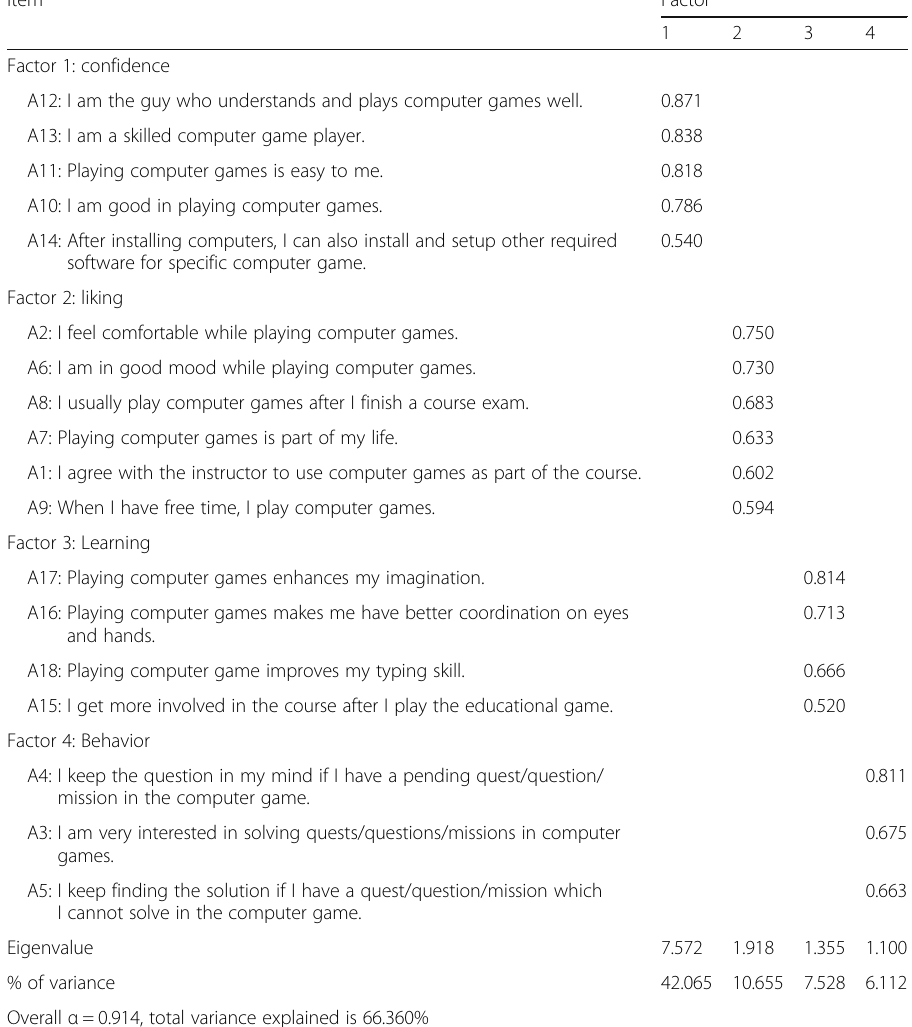
Table 3 Validity analysis results of the revised Computer Game Attitude Scale